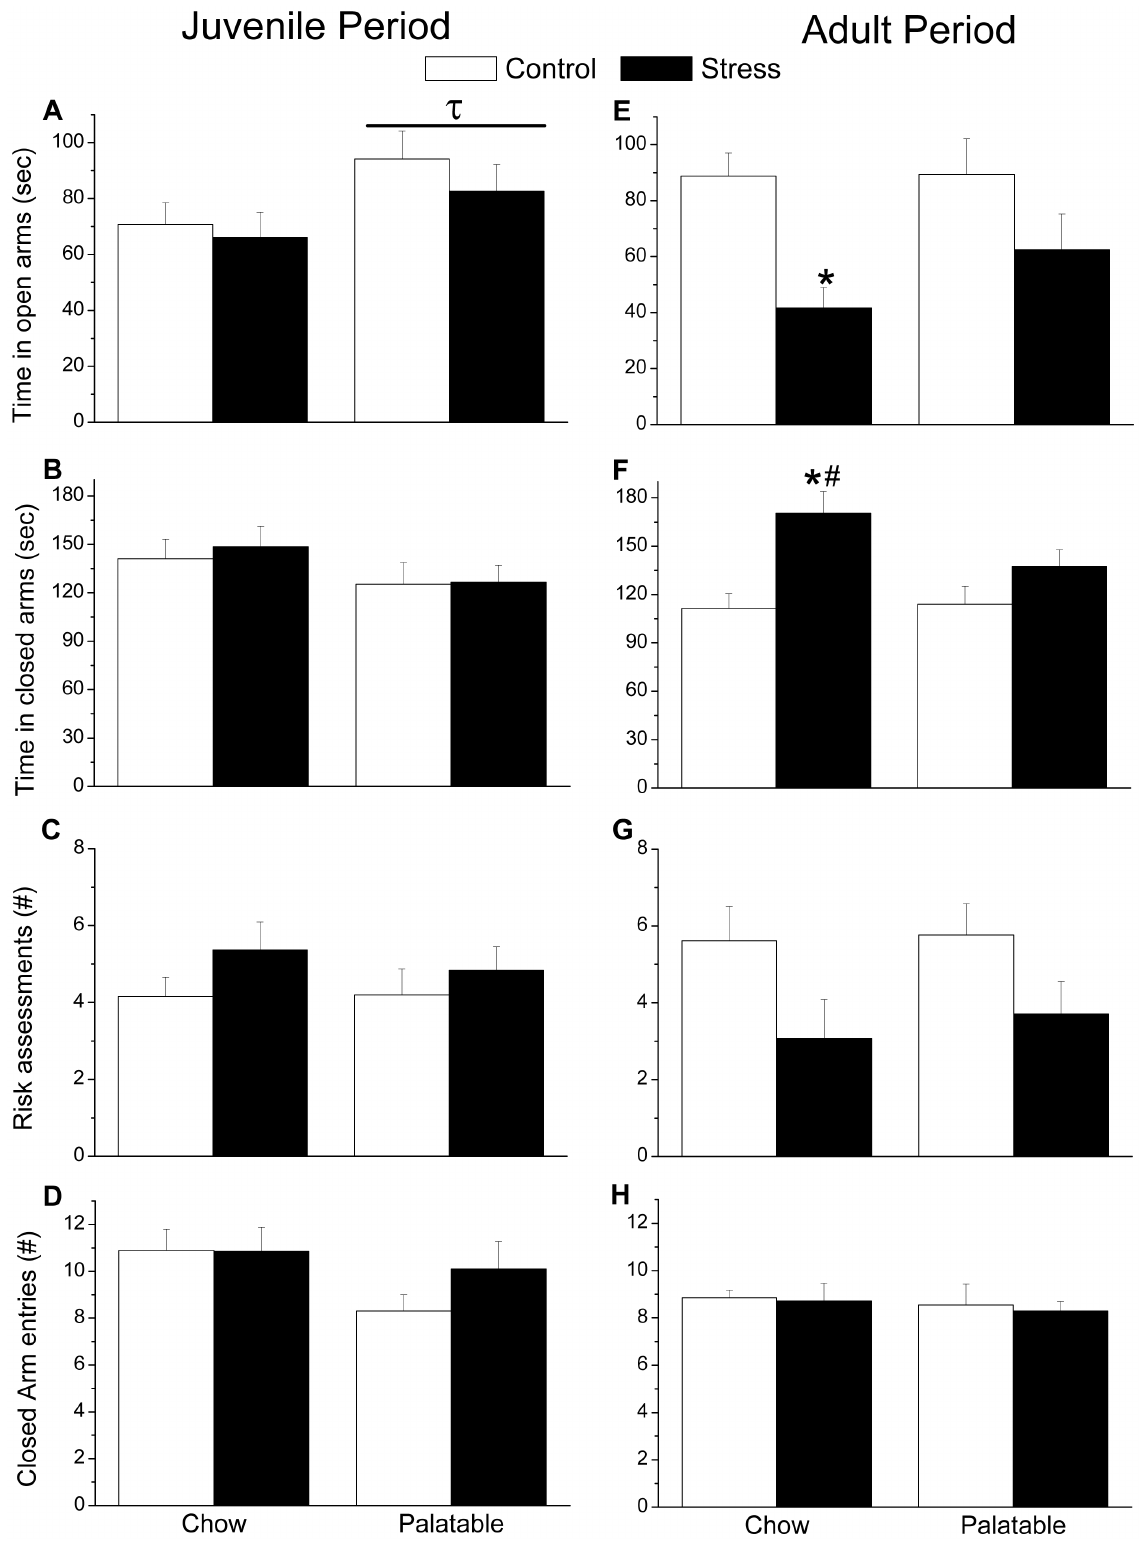
Figure 3. Anxiety-like behavior in the elevated plus maze. A significant effect of the palatable diet was observed in the juvenile time point. In general, rats with access to the palatable diet spent more time in the open arms of the maze. In adulthood, previously stressed chow fed rats (E) spent less time in the open arms, and (F) more time in the closed arms compared to chow fed controls. A significant difference between stress groups was observed in terms of time spent in the close arm with chow-fed rats spending more time relative to palatable food fed counterparts. No significant difference across groups was observed regarding number of (G) risk assessments and closed arms entries (H), suggesting no significant